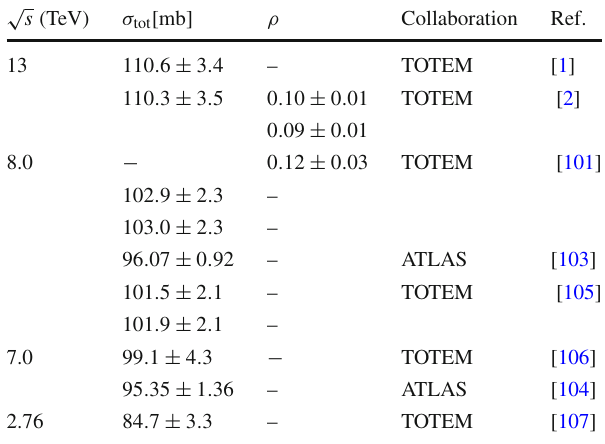
Table 1 Total cross section, σ tot , and ρ -parameter data recently mea- sured by TOTEM and ATLAS Collaborations at the LHC, but not com- piled in the PDG2018 review [100] √ s (TeV) Collaboration Ref.